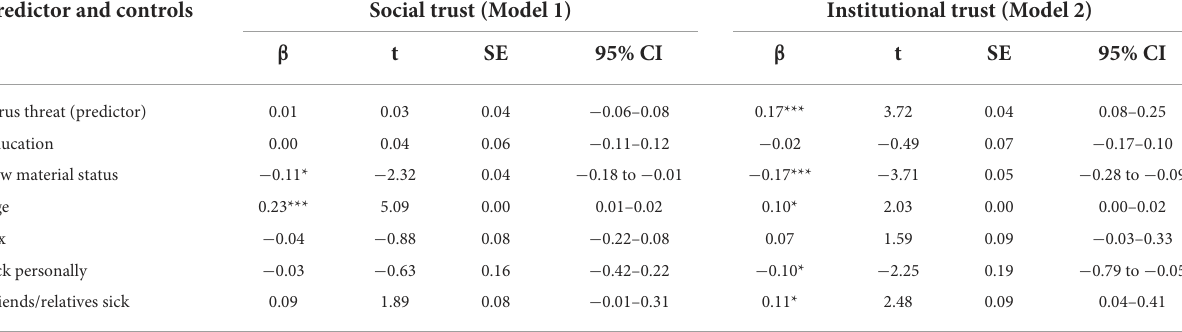
TABLE 2 Relation among perceived coronavirus threat, social and institutional trust (simple linear regression with control of demographic variables, N = 500). Predictor and controls Social trust (Model